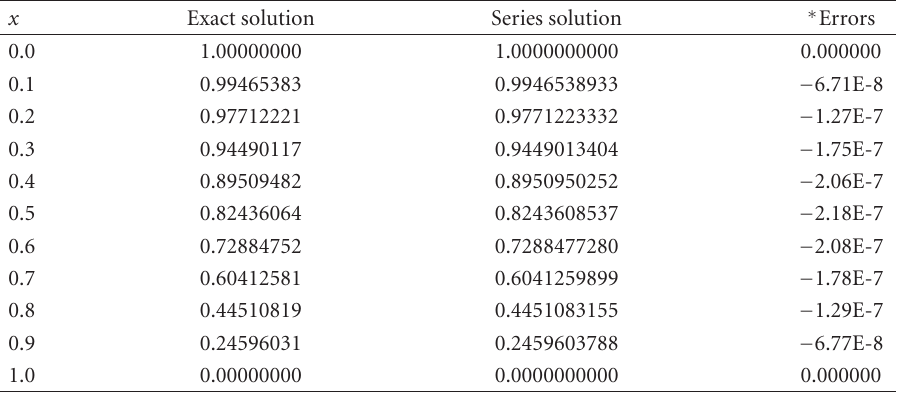
Table 5 . 2 . Error